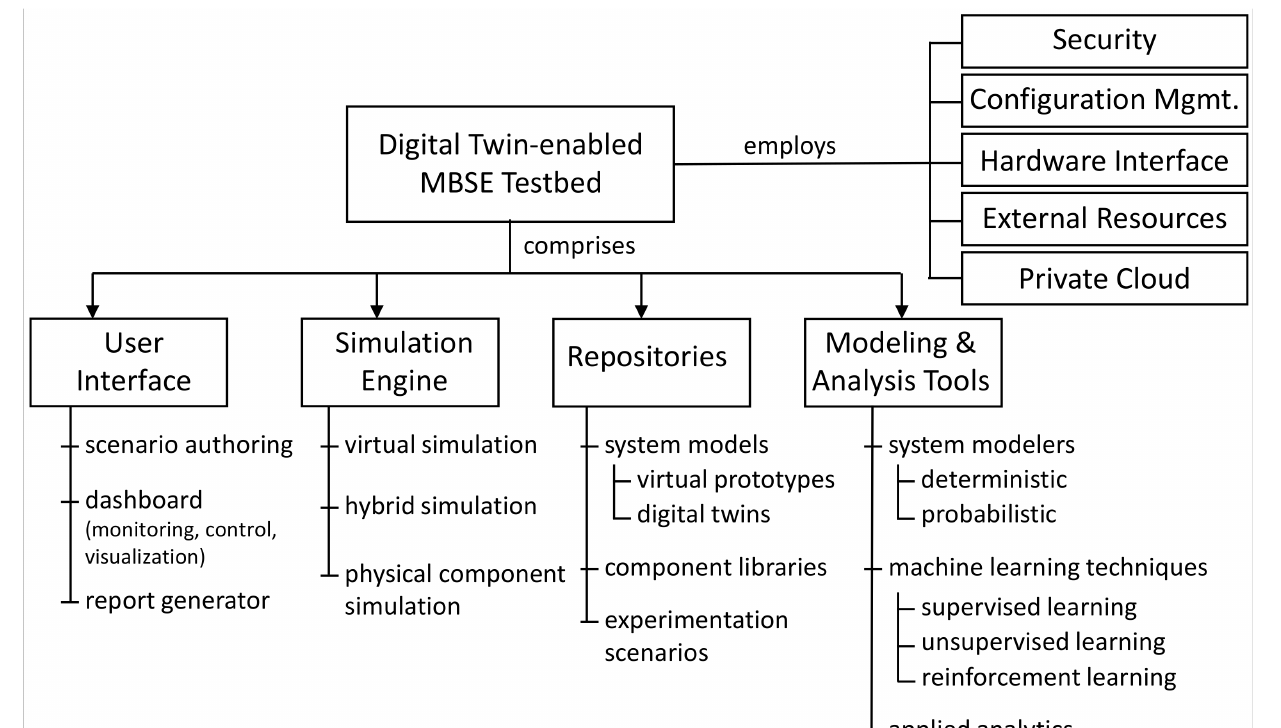
Figure 1. Model-based systems engineering (MBSE) testbed